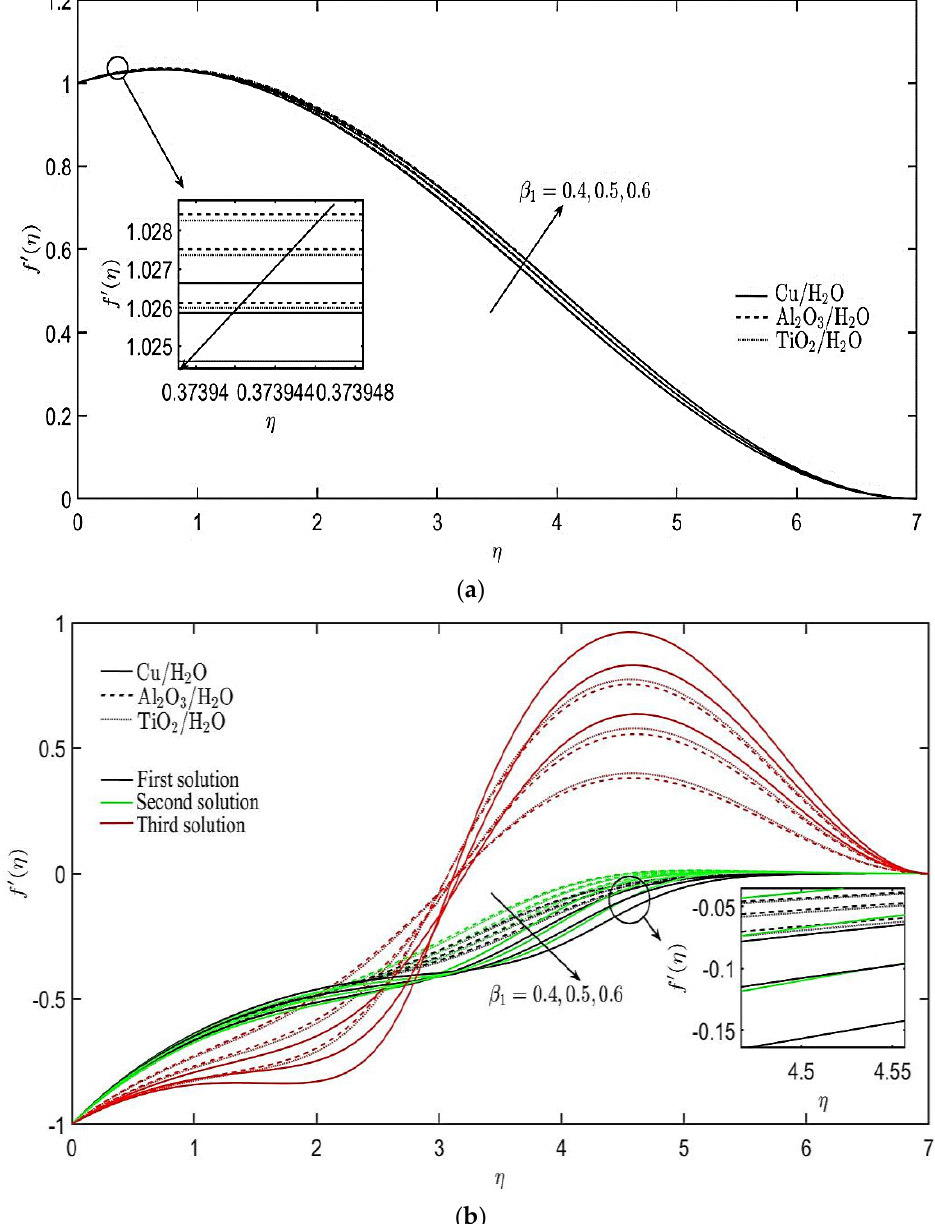
Figure 7. Effect of fluid relaxation time parameter on velocity profile for: ( a ) Stretching case; ( b ) Shrinking case.